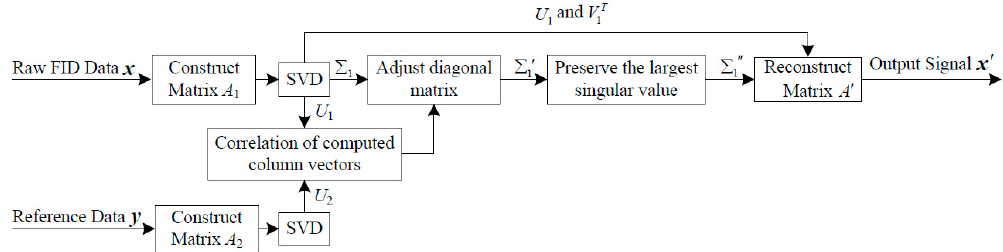
Figure 5. Schematic overview of the ICNR algorithm based on singular value decomposition.